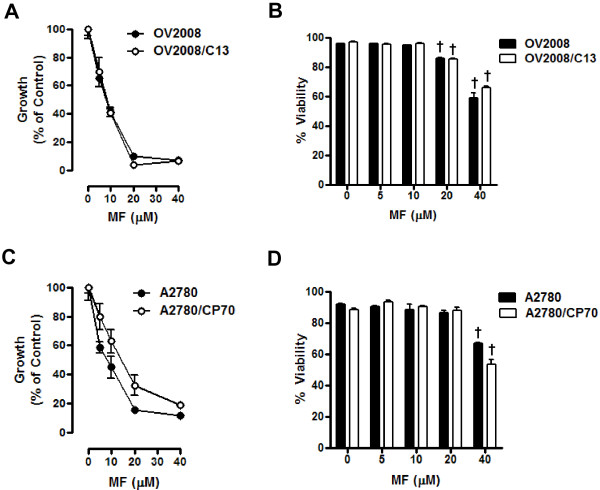
Growth inhibition and lethality of mifepristone towards OV2008, OV2008/C13, A2780 and A2780/CP70 cells. Cells were cultured in the presence of the indicated concentrations of mifepristone for 72 h. (A) and (C), the total number of cells was recorded at the beginning of the experiment and after the 3 days of treatment. The difference between number of cells in vehicle-treated controls at 0 h and after 3 days of culture was considered to be 100%. The growth of the treated groups is expressed as percentage of control. The experiment was repeated three times with different cell line passages to calculate the IC50 (see Table 1 for averaged data). Depicted are representative experiments. (B) and (D), after treatment, viability was assessed by microcapillary cytometry. Results are the average of triplicate counts ± SEM. †p < 0.001 vs. control (0 μM mifepristone) for the respective cell line.